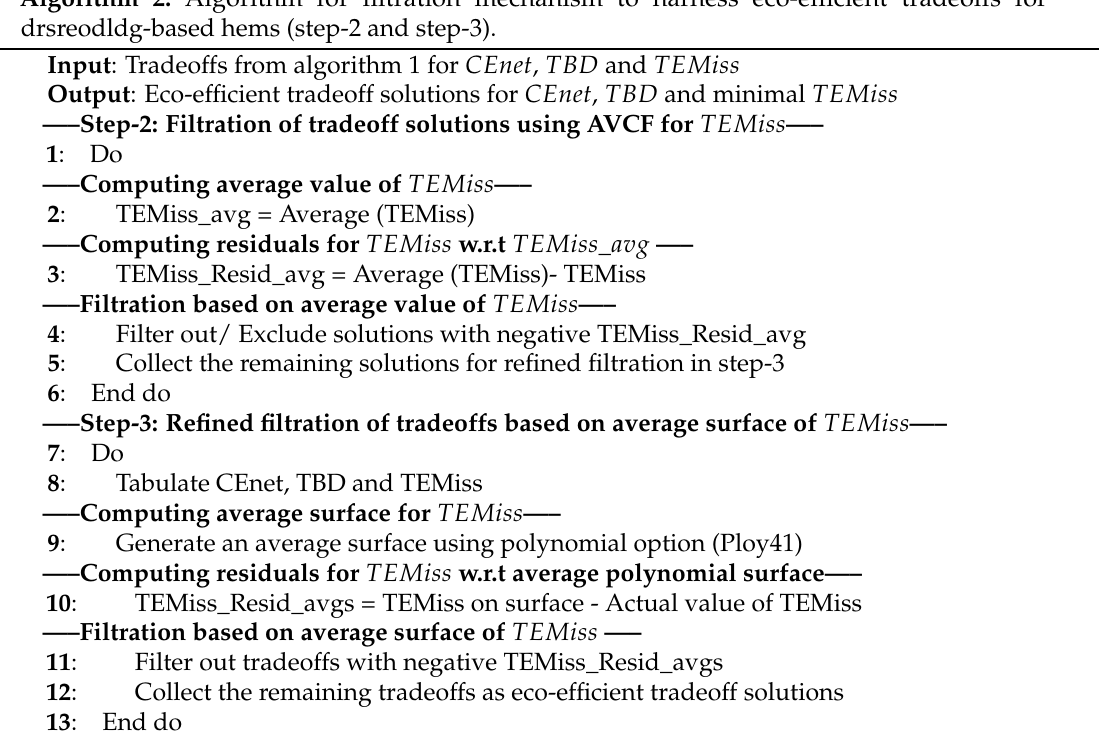
Algorithm 2: Algorithm for filtration mechanism to harness eco-efficient tradeoffs for drsreodldg-based hems (step-2 and